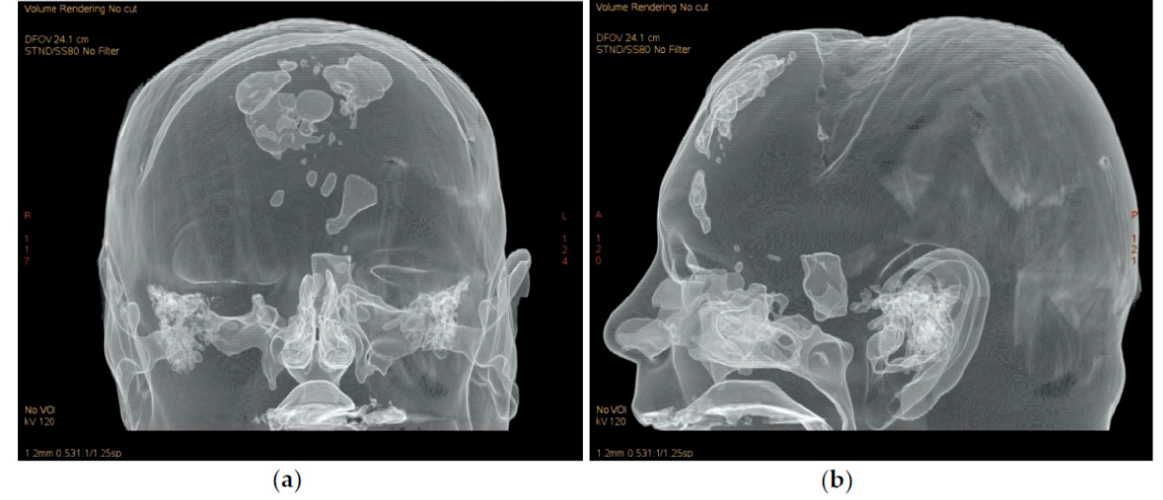
Figure 1. A 3D volume rendering of a CT scan of a patient (no. 12) with pneumocephalus (PNC) following cranialization. ( a ) Coronal view; ( b ) sagittal view.